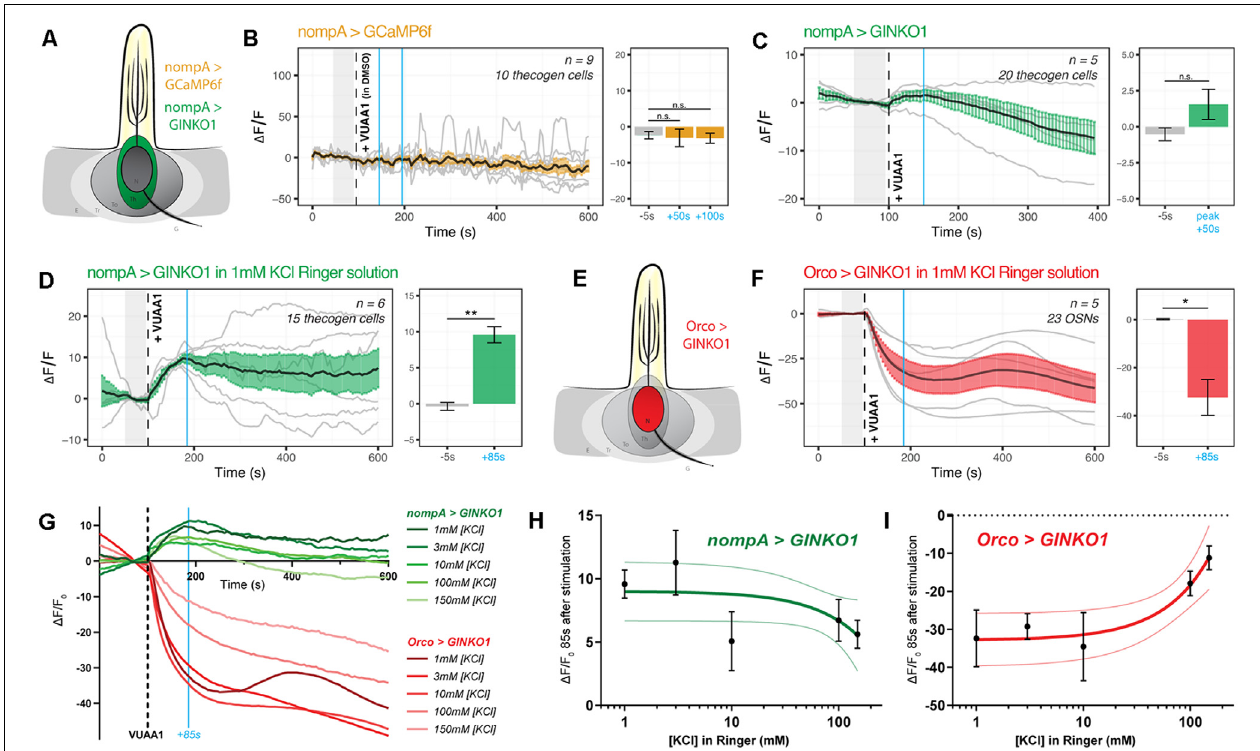
FIGURE 4 | Cation dynamics in thecogen cells during odorant presentation. Thecogen cells are targeted for cation imaging using nompA-GAL4. (A) Imaging paradigm for Ca 2+ and K + in thecogen cells. Both Ca 2+ and K + cation reporters are expressed using the GAL4/UAS system in a nompA promoter-driven manner. (B) Live time course for Ca 2+ imaging during VUAA1 stimulation. No net change in cytoplasmic Ca 2+ in thecogen cells is evident following VUAA1 treatment (This also constitutes a lack of response for the intermediate solvent of VUAA1, DMSO.) (C) Live time course for K + imaging using GINKO1 during VUAA1 stimulation. A small increase in intracellular K + concentration is observed. (D) K + influx is enhanced following VUAA1 treatment at 1 mM KCl, a five-fold low extracellular concentration of K + compared to panel (C) . (E) Illustration of K + imaging in olfactory sensory neurons, as achieved by expressing GINKO1 in cells driven by the Orco promoter-GAL4. (F) K + efflux is observed upon VUAA1 stimulation in olfactory sensory neurons. (G) The plot of average time courses across various extracellular KCl concentrations. Green: K + imaging in thecogen cells, driven by nompA-GAL4. Red: K + imaging in Orco-positive OSNs driven by Orco-GAL4. Cyan line indicates time point at which concentration curves are drawn in the following panel. (H) Concentration curve for responses at 85 s-post VUAA1 treatment in thecogen cells. (I) Concentration curve for responses at 85 s-post VUAA1 treatment in OSNs, indicating an inverse relationship in K + ion concentrations between the two cells. All error bars represent standard errors of the mean (SEM). Vertical blue lines indicate time points compared on each time course’s respective bar graphs. Paired student’s t -tests were used to compare time points. Asterisks indicate statistical significance ( n.s. not significant, * p ≤ 0.05, ** p ≤